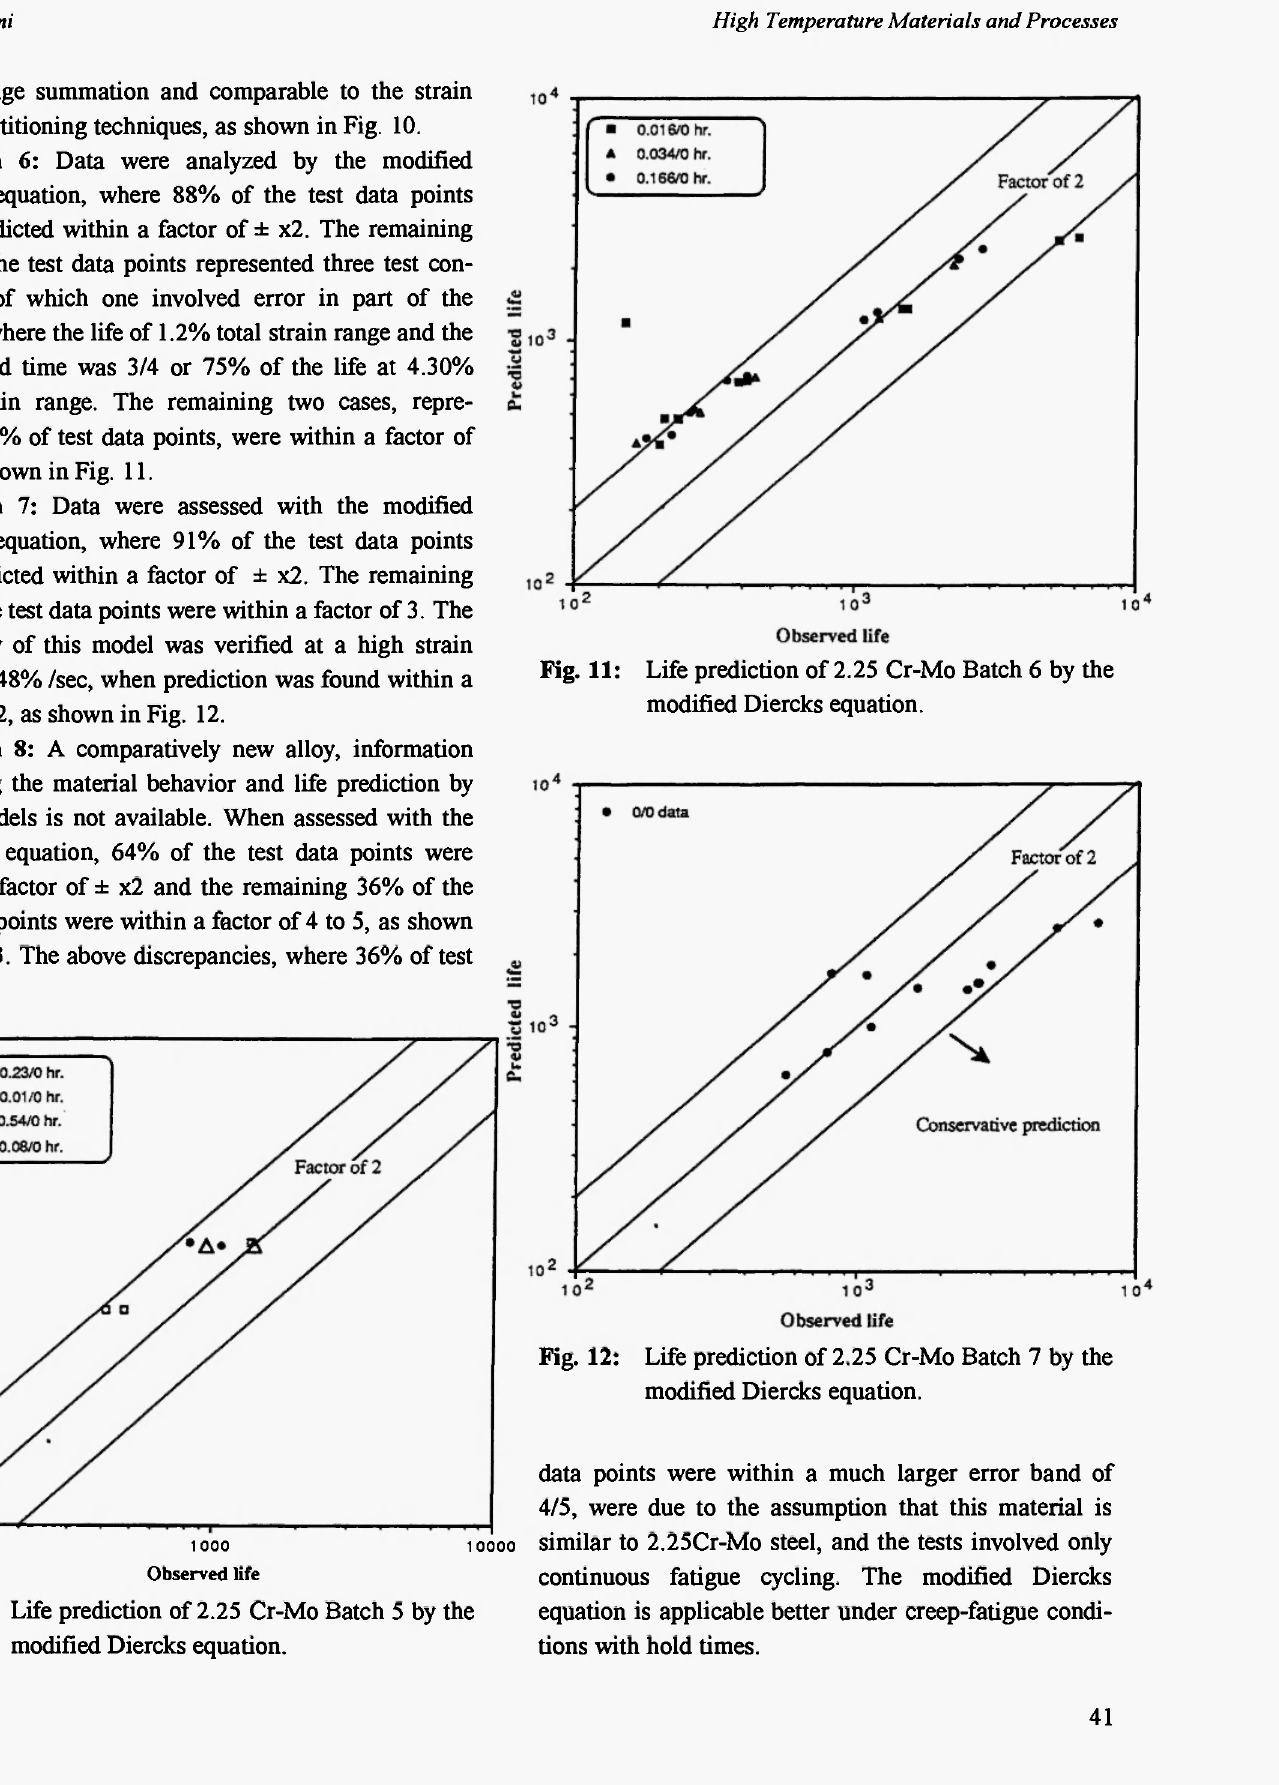
Fig. 10: Life prediction of 2.25 Cr-Mo Batch 5 by the modified Diercks equation.